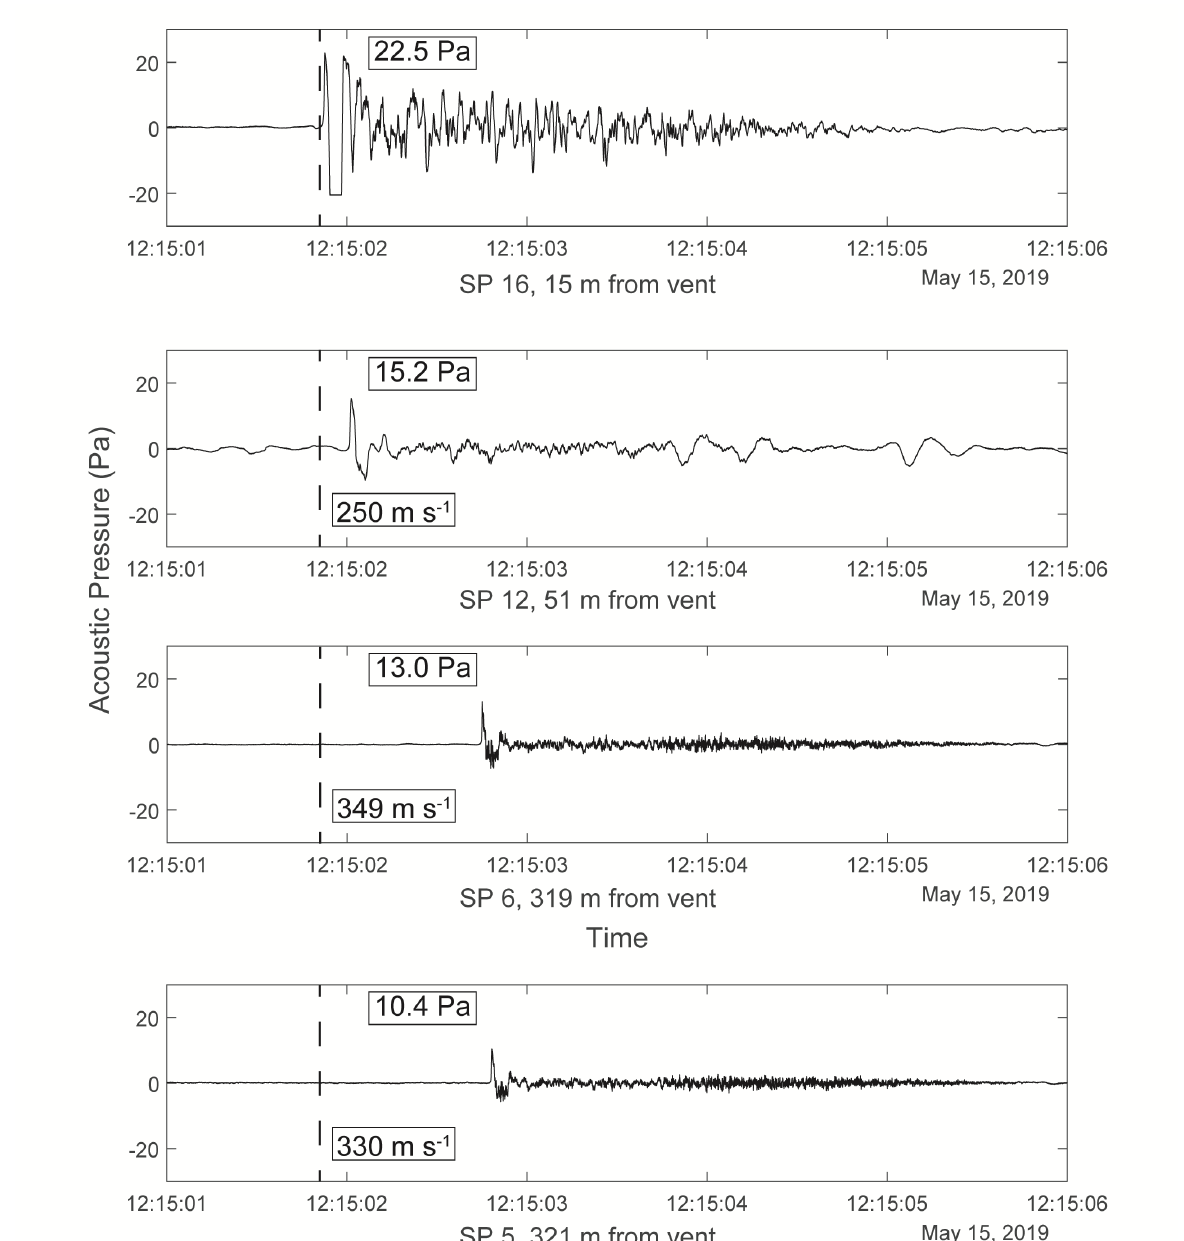
Figure 5: Acoustic pressure recorded on 15 May 2019 at 12:14 UTC by the sensors 16, 12, 5, and 6. Their vent distances range were between 15 and 321 m. The dashed line represents the onset of the acoustic event as measured by sensor 16. The boxes show the peak pressure of the first positive peak and the calculated speed of sound based on arrival times and distances between the sensors,